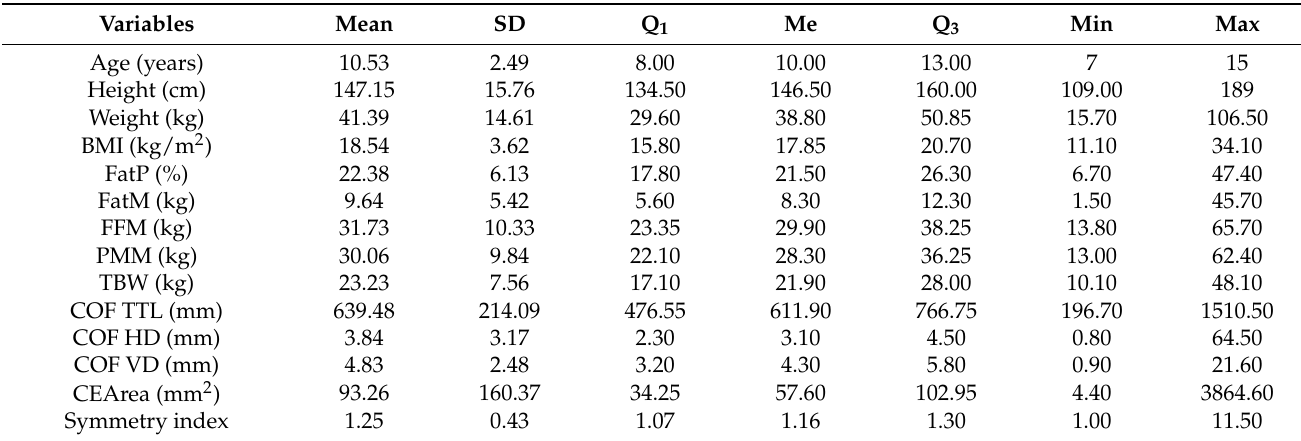
Table 1. Characteristics of the study